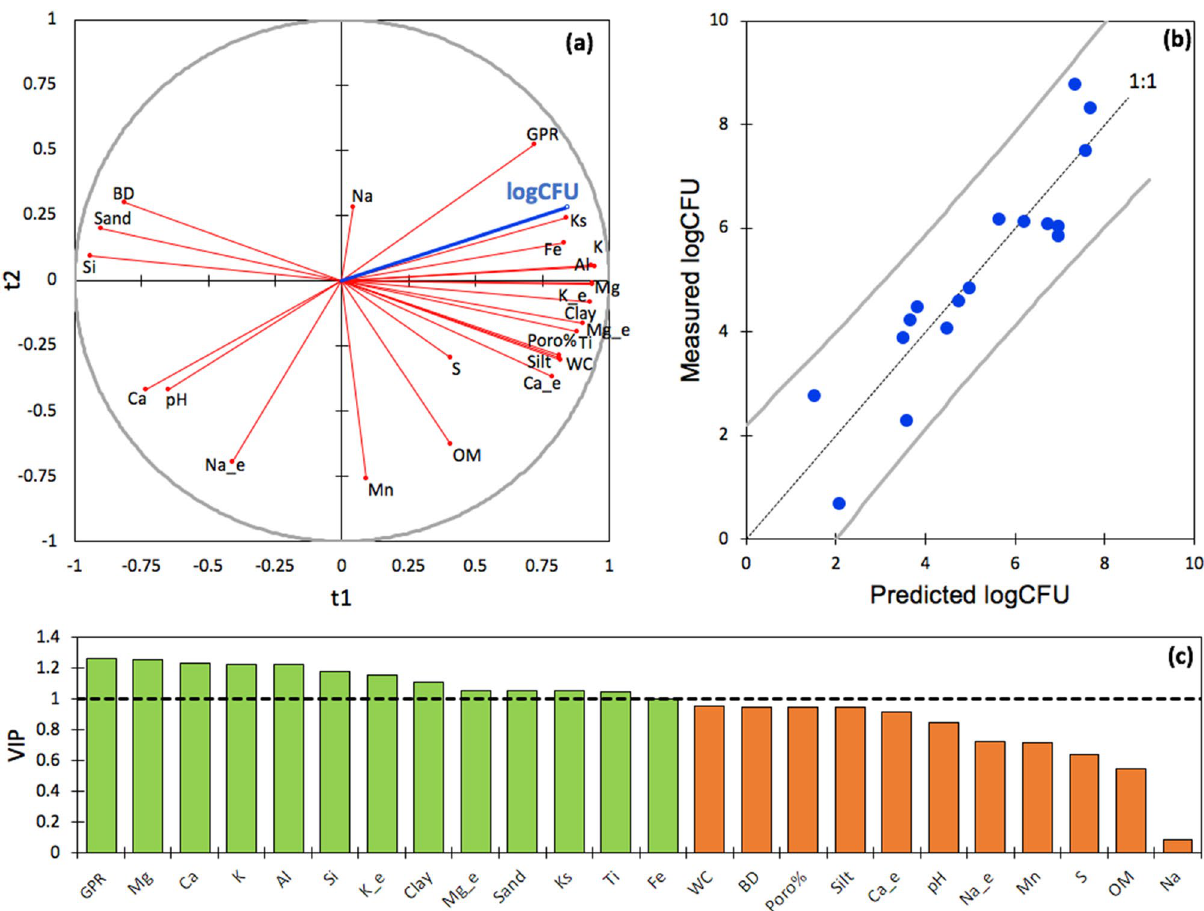
Figure 7. Partial Least Squares Regression (PLS-R) analysis where the natural logarithm of the semi- quantitative colony forming unit (CFU) counts of B. pseudomallei (logCFU) are compared with soil